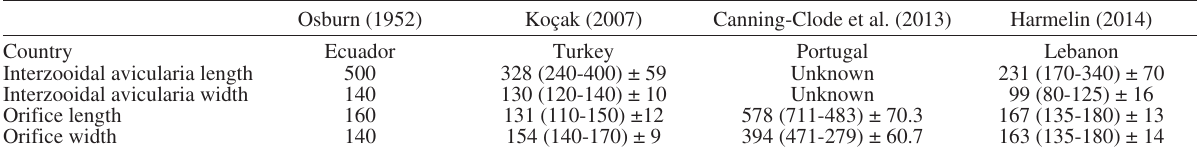
Table 3. – Average dimensions of interzooidal avicularia and orifice dimensions (μm) of Celleporaria brunnea specimens from Osburn (1952), Koçak (2007), Canning-Clode et al. (2013); and of Celleporaria sp. aff. brunnea from Harmelin (2014). Minimum-maximum ± standard deviation values, are also reported, if available.